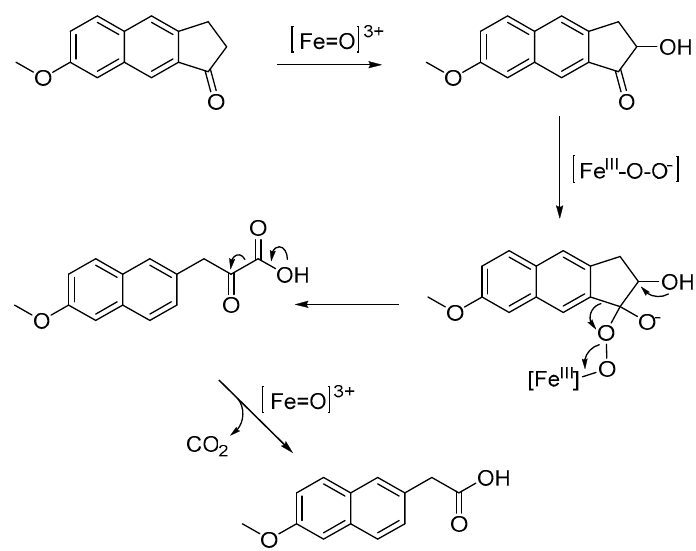
Figure 7. Hypothetic mechanism for the Cytochrome P450-catalyzed metabolism of A.